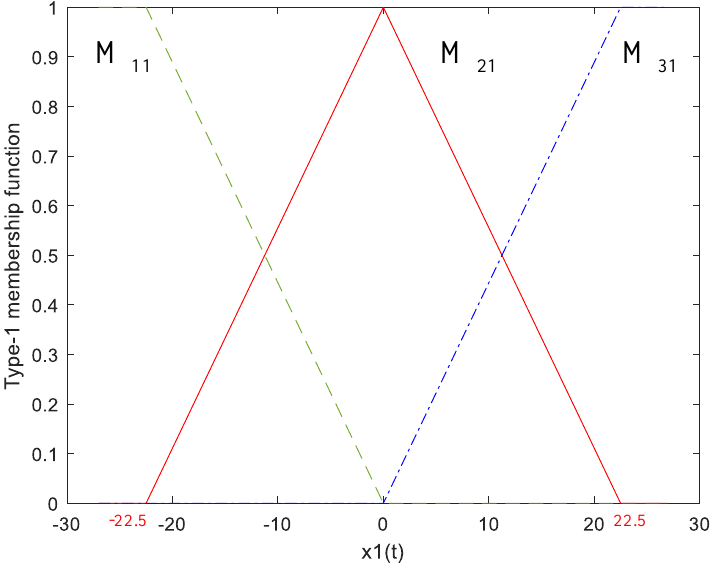
Figure 13. Type-1 membership functions of boiler system. Different from the membership function designed in Figure 2, the factor of uncer- tainties is not considered in the type-1 fuzzy modeling. Referring to the IT-2 T–S fuzzy model (20)–(22), the type-1 T–S fuzzy model of the nonlinear multi-boiler system (11)–(14) can be expressed as follows based on the membership function in Figure